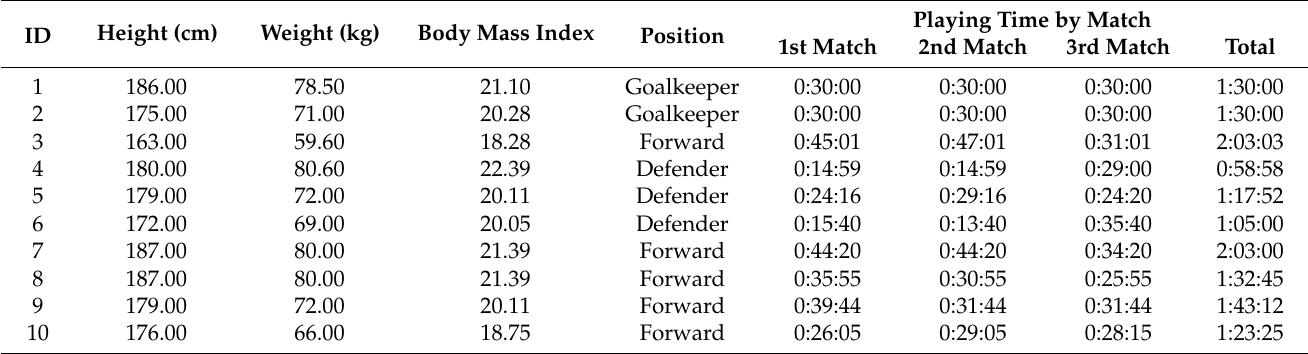
Table 1. Descriptive analysis of the